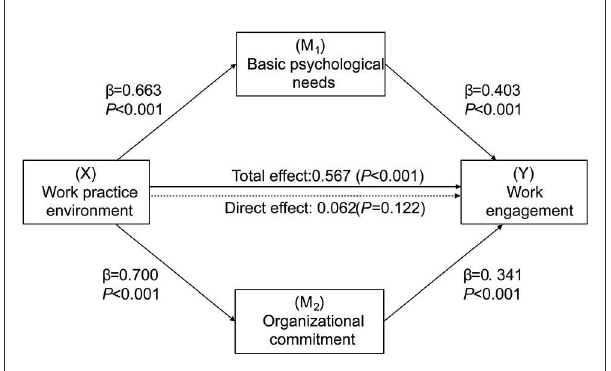
FIGURE2 Final model and standardized model